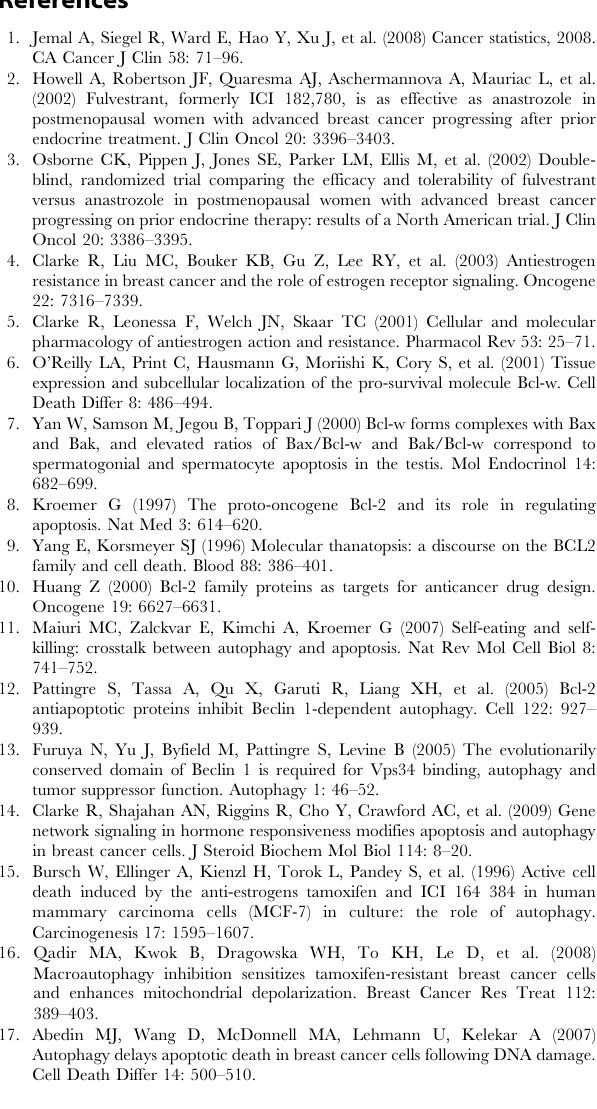
represent the mean 6 SE of relative proliferation (normalized to empty vector control). ANOVA p , 0.001; p , 0.001 for YC137 + ICI treated cells vs. ICI treated cells. Figure S3 BCL-W/BCL2 inhibition decreases cell proliferation in ICI 182,780 treated resistant LY2 cells. Cells were treated with ICI, YC137, or a combination of the two for 7 days to examine cell proliferation. Bars represent the mean 6 SE of relative proliferation (normalized to empty vector control). ANOVA p , 0.001; p , 0.05 for treatment vs. control treated cells and for YC137 + ICI treated cells vs. YC137 and ICI. Figure S4 Combined autophagy inhibition and BCL-W/BCL-2 inhibition does not alter cell cycle distribution in the resistant cell line. Cells were treated with ICI, 3MA, YC137, or a combination for 48 h prior to ethanol fixation and FACS analysis. ANOVA p = 0.016; p , 0.05 for treatment vs. control, 3MA, or YC137. Found at: doi:10.1371/journal.pone.0008604.s004 (0.56 MB TIF) Figure S5 BCL-W and BCL2 indirectly regulate necrosis through the direct regulation of autophagy and apoptosis.